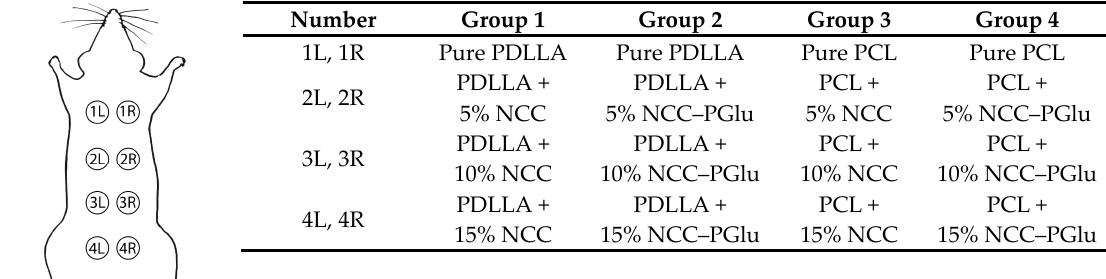
Figure 1. Scheme of implantation of the specimens and groups of animals. Each group included three rats to whom the specimens were implanted twice, e.g. on the left and the right side from the backbone of the same animal. The total number of repeats for composite materials was 6; for pure aliphatic polyester specimens, it was 12. NCC: nanocrystalline cellulose, PCL: poly( ε -caprolactone), PDLLA: poly (D,L-lactic acid), PGlu: poly(glutamic acid). Scaffold resection. At the end of the experiment, the animals were euthanized with Zoletil ® (Virbac, Carros, France) (total dose—60 mg/kg; active components: tyletamine hydrochloride and